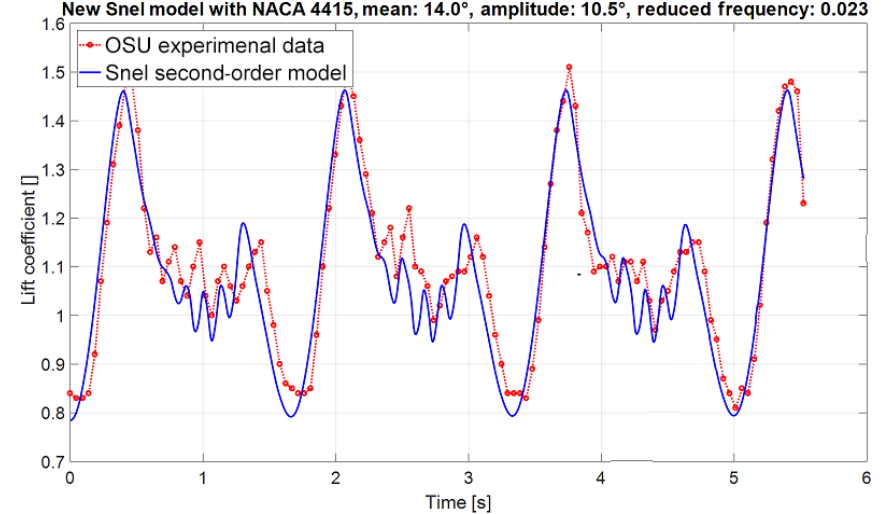
Figure 7. Lift coefficient over time of the improved Snel model (NACA 4415 aerofoil with mean angle of attack of 14 ◦ , amplitude of 10.5 ◦ , and reduced frequency of